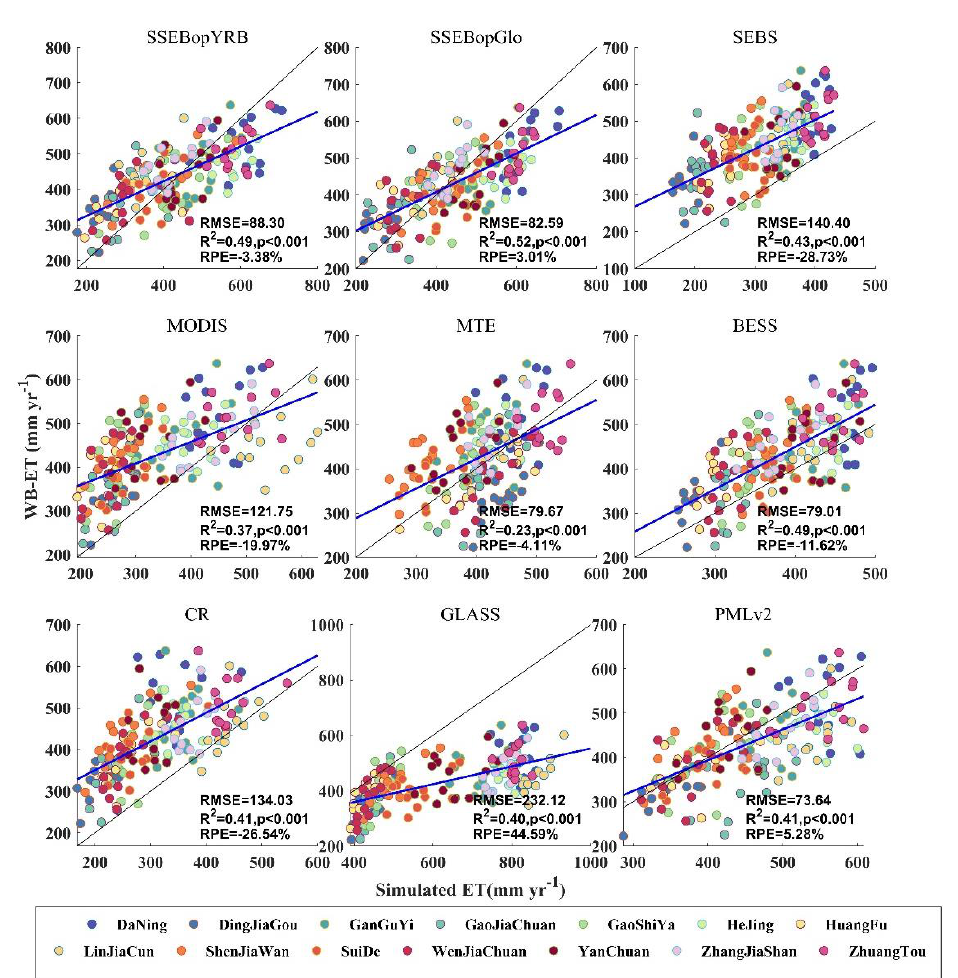
Figure 3. Evaluation of the annual ET at fourteen small catchment sites in ET SSEBopYRB and evaluation of eight other ET products during 2003–2015. The blue line is the fitted line and the black line is the 1:1 line.